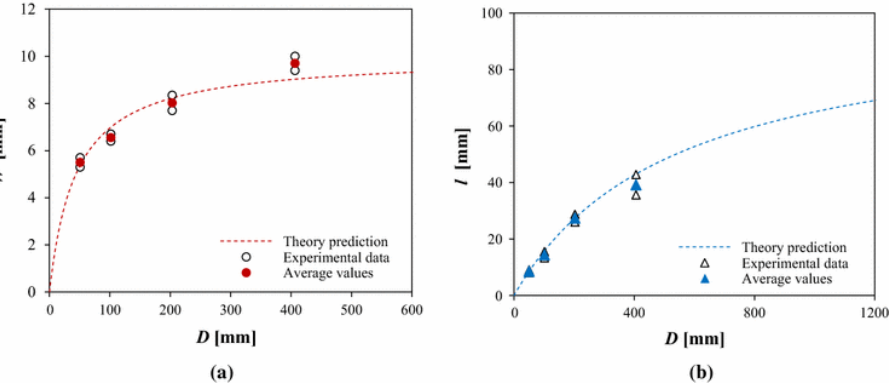
Figure 8. The influence of the specimen size on the FPZ size. ( a) Width. ( b) Length. ( W and l are the width and length of the PFZ, respectively; D is the diameter of the specimen.) Reprinted with permission from Ref. [173]. Copyright 2017, Springer Nature.